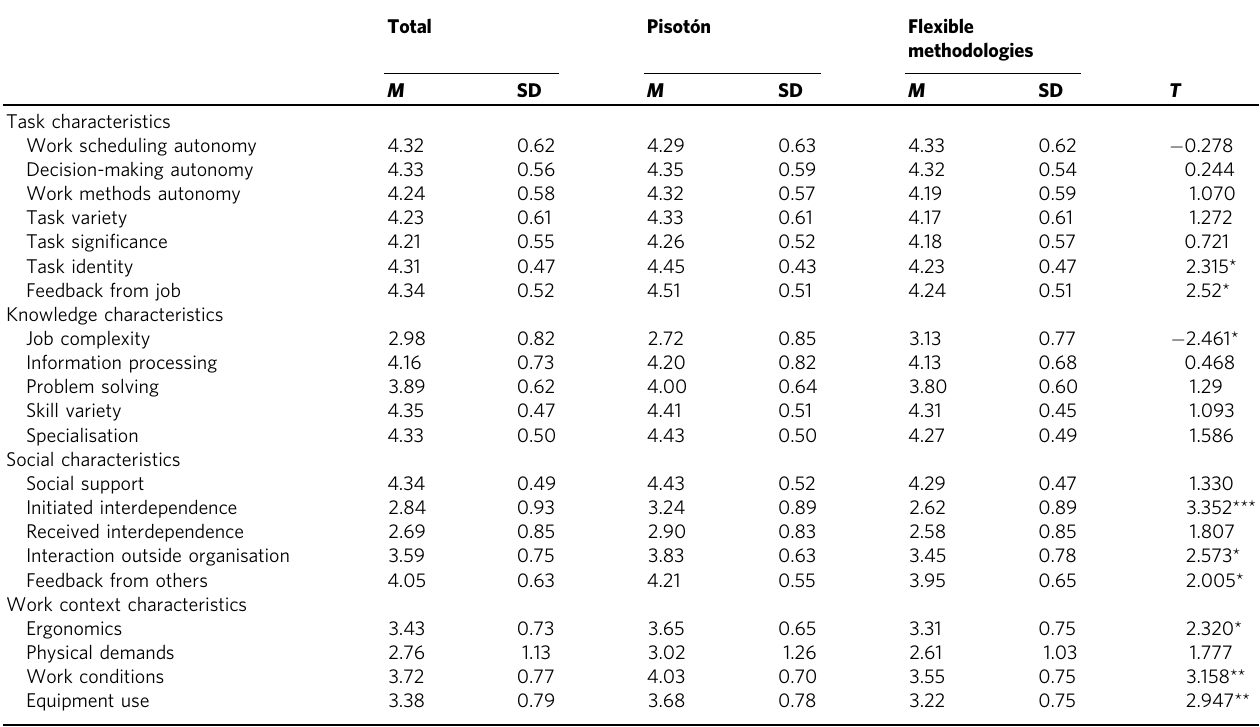
Table 4 Characteristics of the work at the participating schools. Total Pisotón Flexible